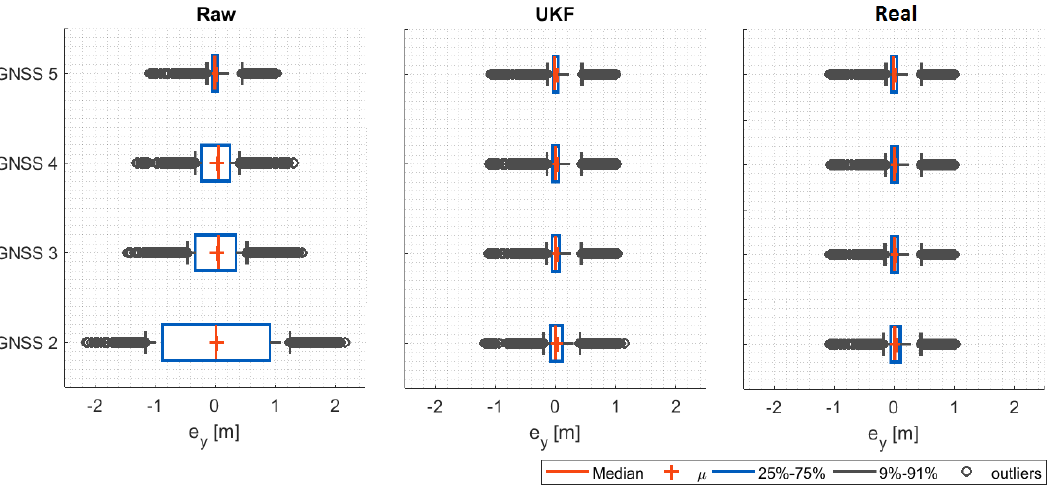
Figure 9. Lateral error under different GNSS positioning